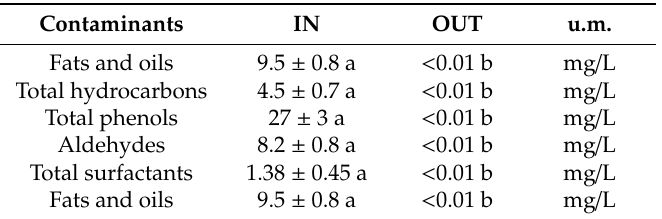
Table 2. Organic contaminants previous and after phytodepuration. The values after the CW treatment were significantly di ff erent ( p -value <